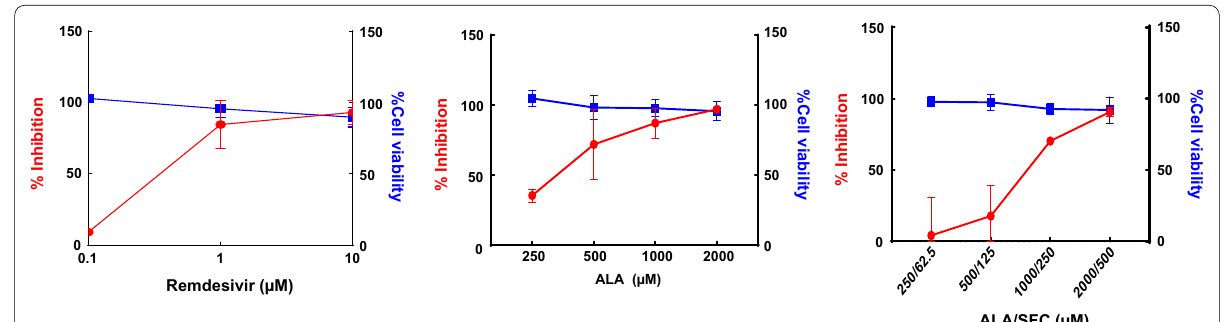
Fig. 1 Antiviral effect of remdesivir ( A ) 5-ALA ( B ) and 5ALA with SFC ( C ) against SARS-CoV-2 Omicron variant. Vero E6 cells were pretreated with remdesivir, ALA with and without SFC for 72 h and challenged with SARS-CoV-2. Infected cell supernatants at 48 h pi (MOI 0.02) were quantified by quantitative real time RT-PCR assay. The blue and red lines represent the CC 50 and IC 50 , respectively; the blue squares represent cell viability (%) and the red circles represent SARS-CoV-2 infection inhibition (%). Data were collected from at least two independent experiments (in replicate) and shown data correspond to the mean SD ±